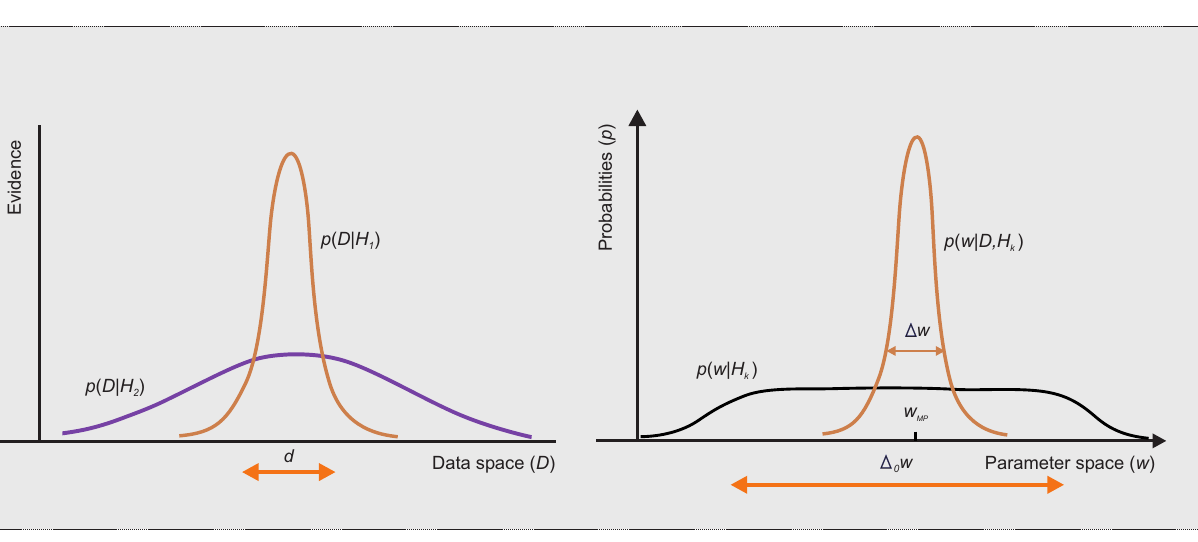
Figure 4. Occam’s